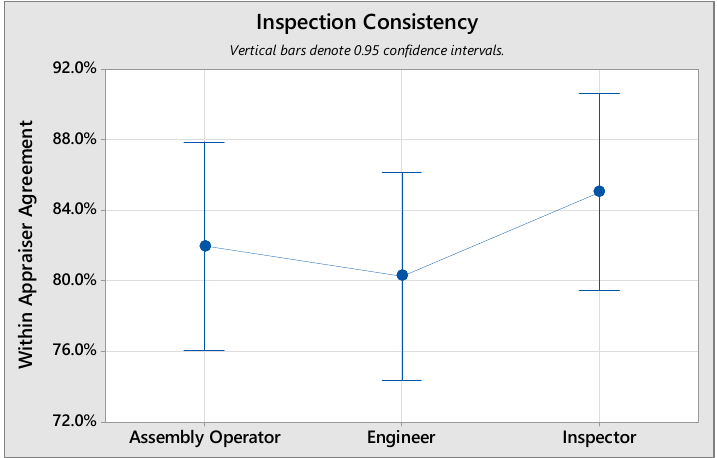
Figure 6. Effect of expertise on inspection consistency. Data for static images only, without the usual ability to view the blade from different perspectives and tactile feeling of the blade.